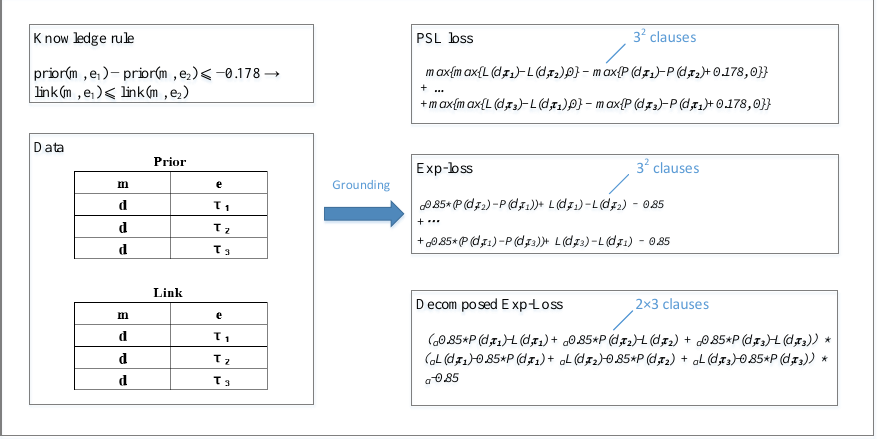
Figure 3. Example of the comparison of the proposed framework. PSL, Probabilistic Soft